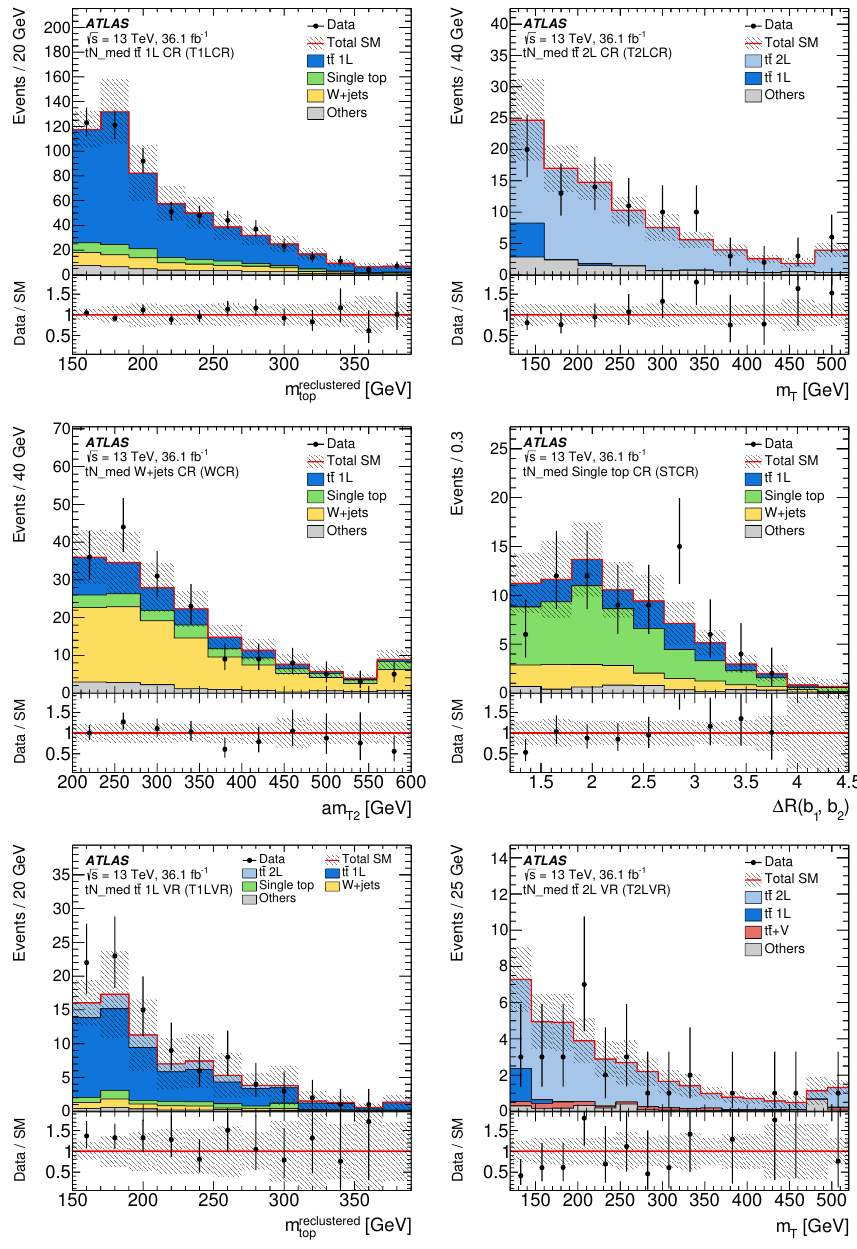
Figure 9 . Various kinematic distributions in the tN med control and validation regions: (top left) reclustered jet mass ( m reclustered ) in the semileptonic t (cid:22) t control region, (top right) m T in the dilep- top tonic t (cid:22) t control region, (middle left) am T2 in the W +jets control region, (middle right) (cid:1) R ( b 1 , b 2 ) in the single-top control region, (bottom left) reclustered jet mass ( m reclustered ) in the semileptonic top t (cid:22) t validation region, and (bottom right) m T in the dileptonic t (cid:22) t validation region. Each of the back- grounds is scaled by a normalisation factor obtained from a simultaneous likelihood (cid:12)t of the CRs. The category labelled ‘Others’ stands for minor SM backgrounds that contribute less than 5% of the total SM background. The hatched area around the total SM prediction and the hatched band in the Data/SM ratio include statistical and experimental uncertainties. The last bin contains